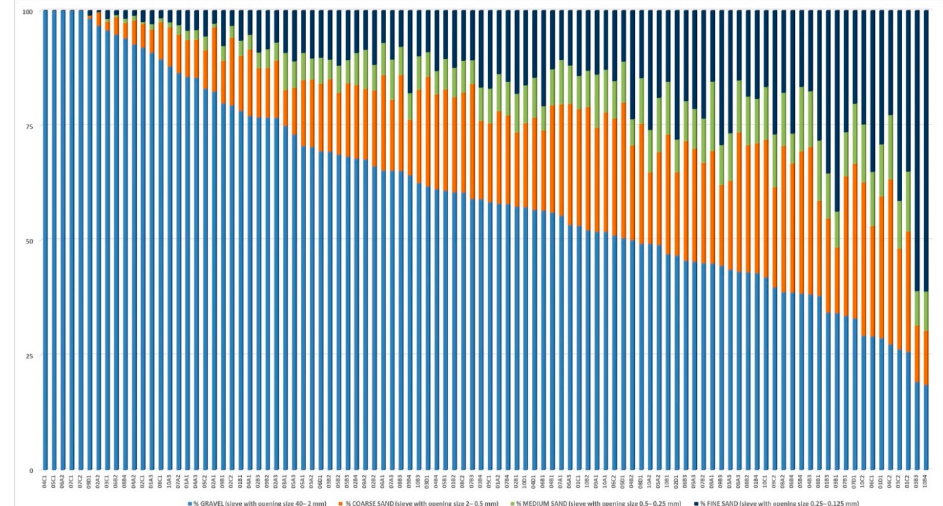
Figure 3. The proportions of different grain sizes of 100 mining residues samples in accordance with the textural classification system of the U.S. Department of Agriculture (USDA, 1951).